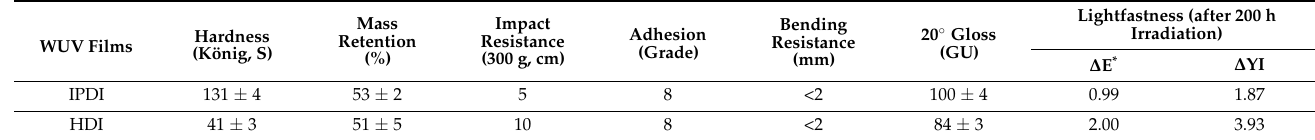
Table 3. Fundamental properties of WUV films synthesized with IPDI and